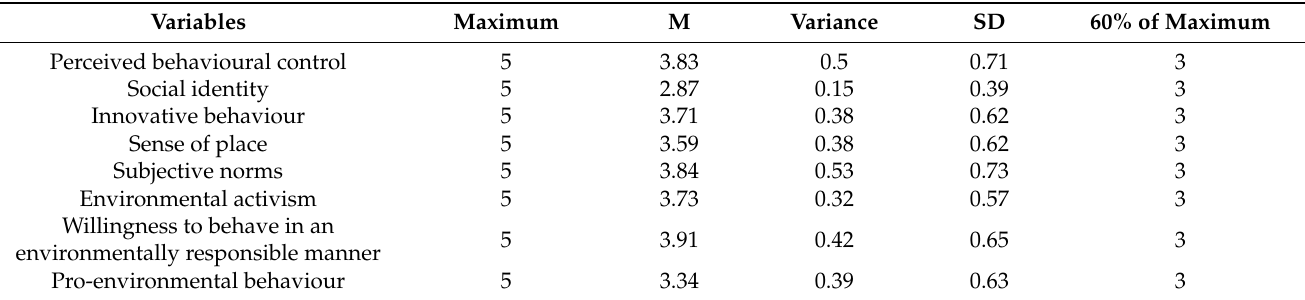
Table 3. Descriptive statistics.